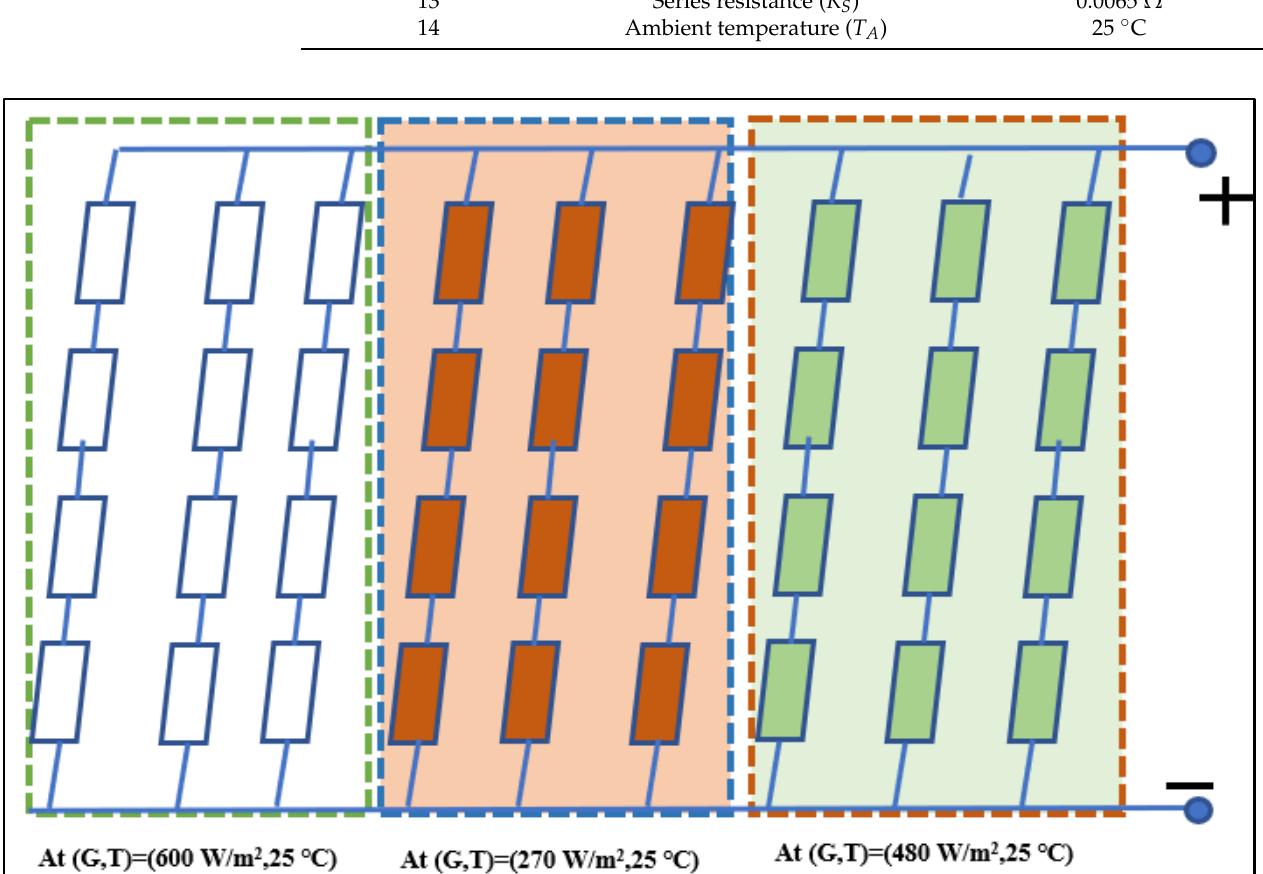
Figure 9. A 40-watt solar panel.